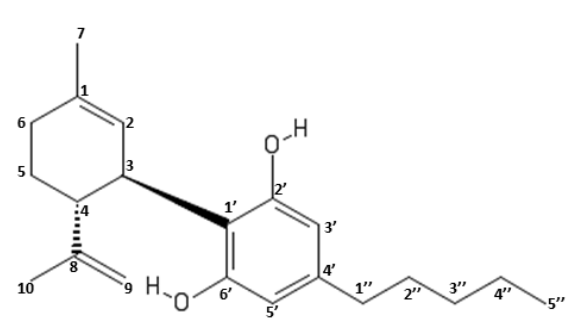
Figure 2. Chemical Structure and numbering system of Cannabidiol (CBD).